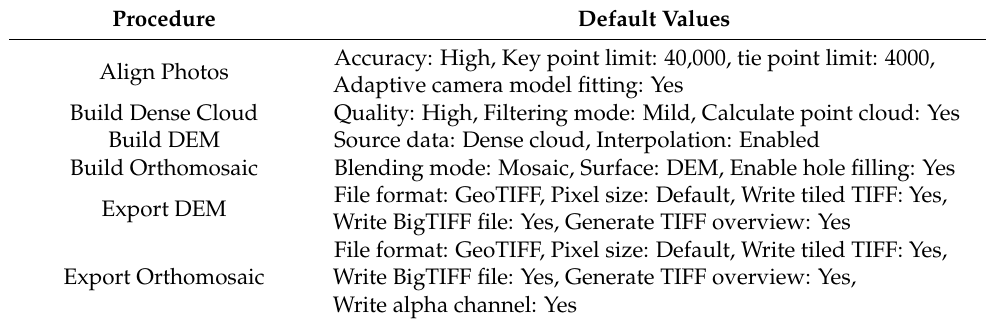
Table 3. SfM processing pipeline and